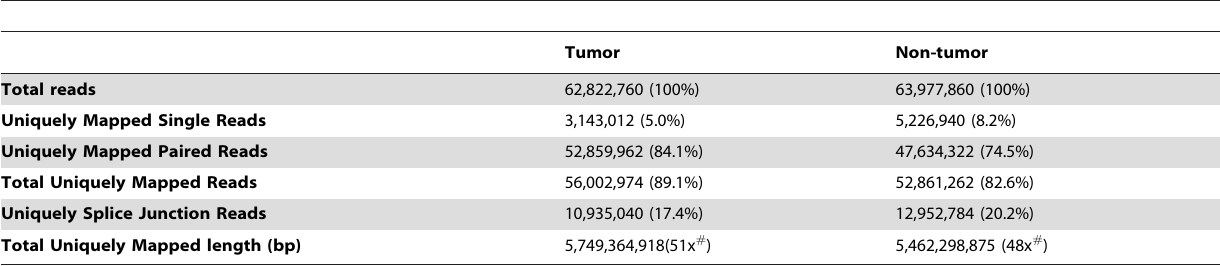
Table 1. Statistics of bladder cancer transcriptome mapping to human genome